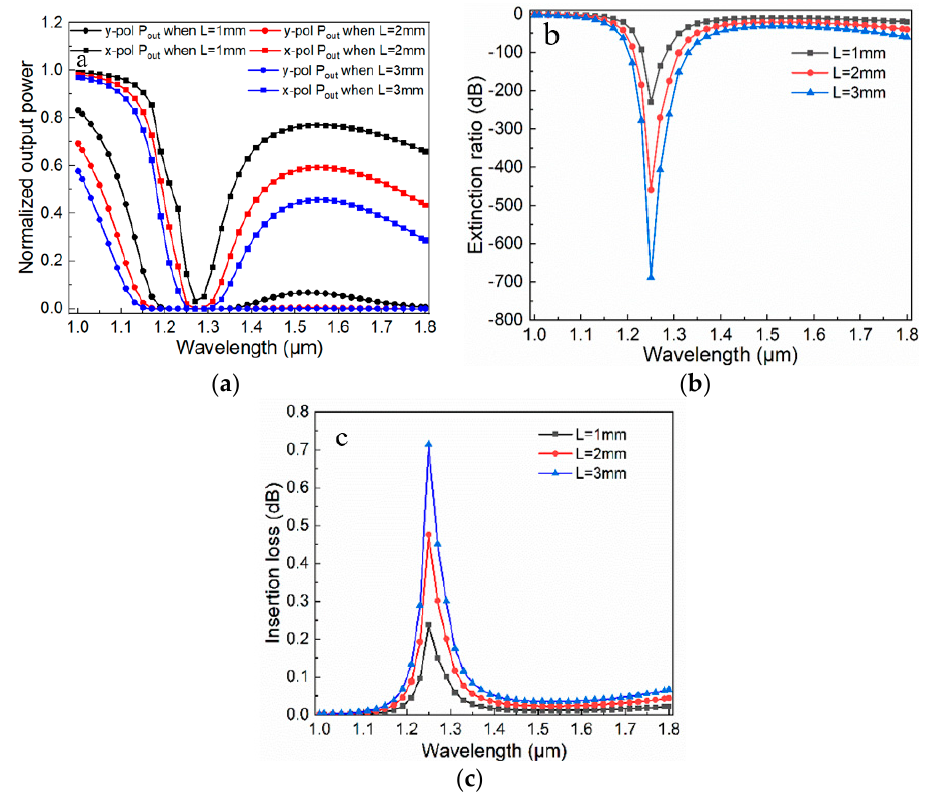
Figure 7. Performance parameters versus wavelength with different fiber lengths L for the proposed filter. ( a ) Normalized output power versus wavelength. ( b ) Extinction ratio versus wavelength. ( c ) Insertion loss versus wavelength.